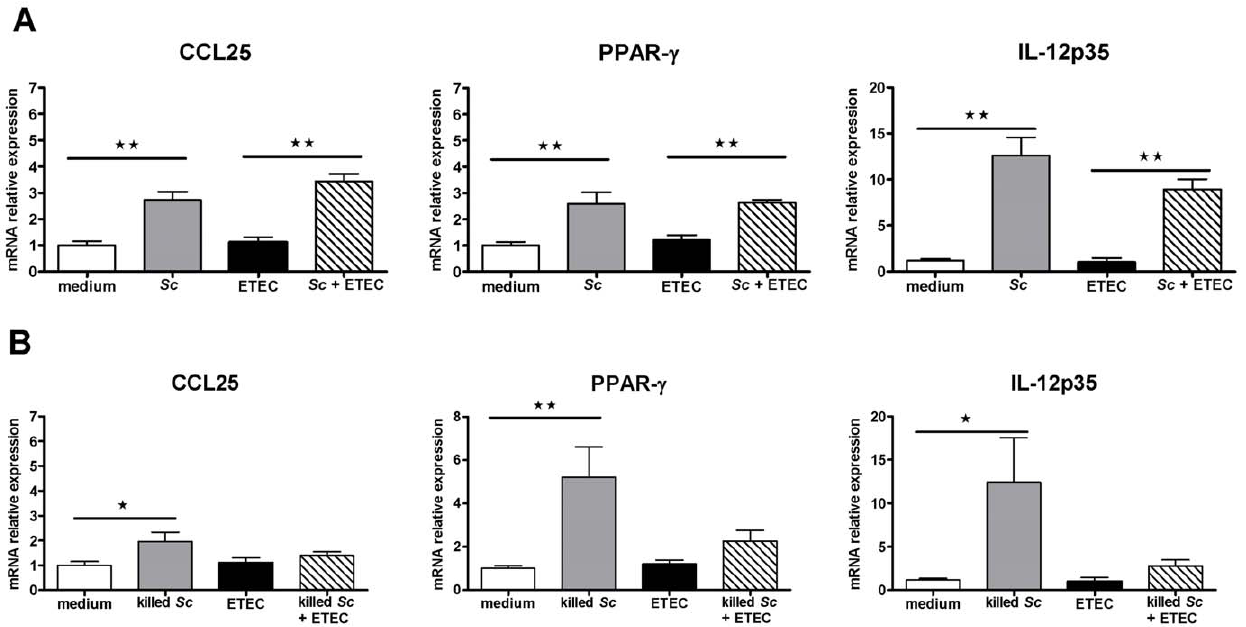
Figure 3. Saccharomycescerevisiae up-regulates CCL25, PPAR- c and IL-12p35 mRNA relative expressions. Differentiated IPEC-1 cells were cultured overnight with (A) viable Sc or (B) killed Sc (3 6 10 6 yeasts/well) and then ETEC (3 6 10 7 CFU/well) was added to the co-culture for 3 h. Gene expression was analysed by RT-qPCR. Data are presented as means 6 SEM ( n =6), asterisks denote: * ( P , 0.05 ), ** ( P , 0.01 ). (A) Data are representative of three independent experiments.